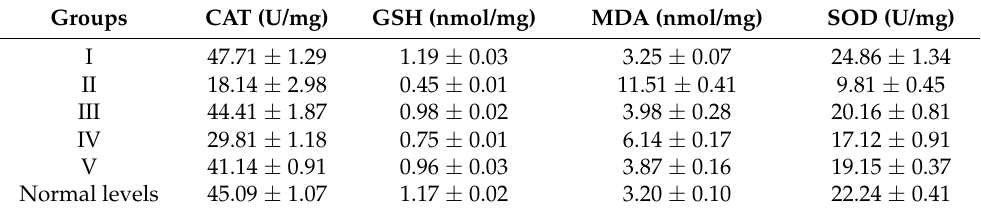
Table 7. Influence of LUT-SNEDDS (LSN1) and LUT administrations on different biomarkers of rat liver.